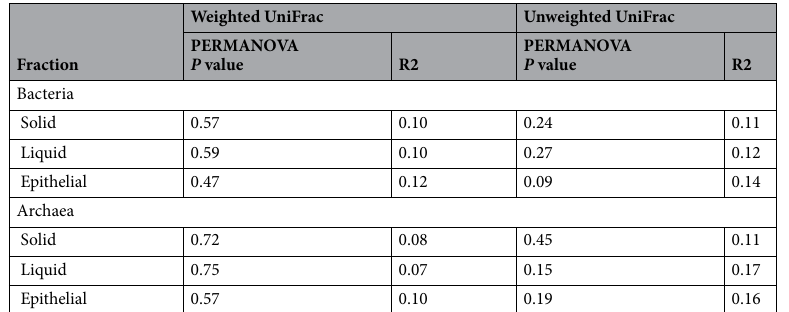
Table 3. Beta diversity analysis. Effect of breed on bacterial and archaeal community composition in solid, liquid and epithelial ruminal fractions. Community dissimilarities calculated using weighted and unweighted UniFrac distances and compared among breeds using PERMANOVA, with P values and R2 values reported. Solid (Cheviot n = 8, Connemara n = 5, Lanark n = 9, Perth n = 7), liquid (Cheviot n = 9, Connemara n = 5, Lanark n = 9, Perth n = 5), epithelial (Cheviot n = 9, Connemara n = 3, Lanark n = 6, Perth n = 8).